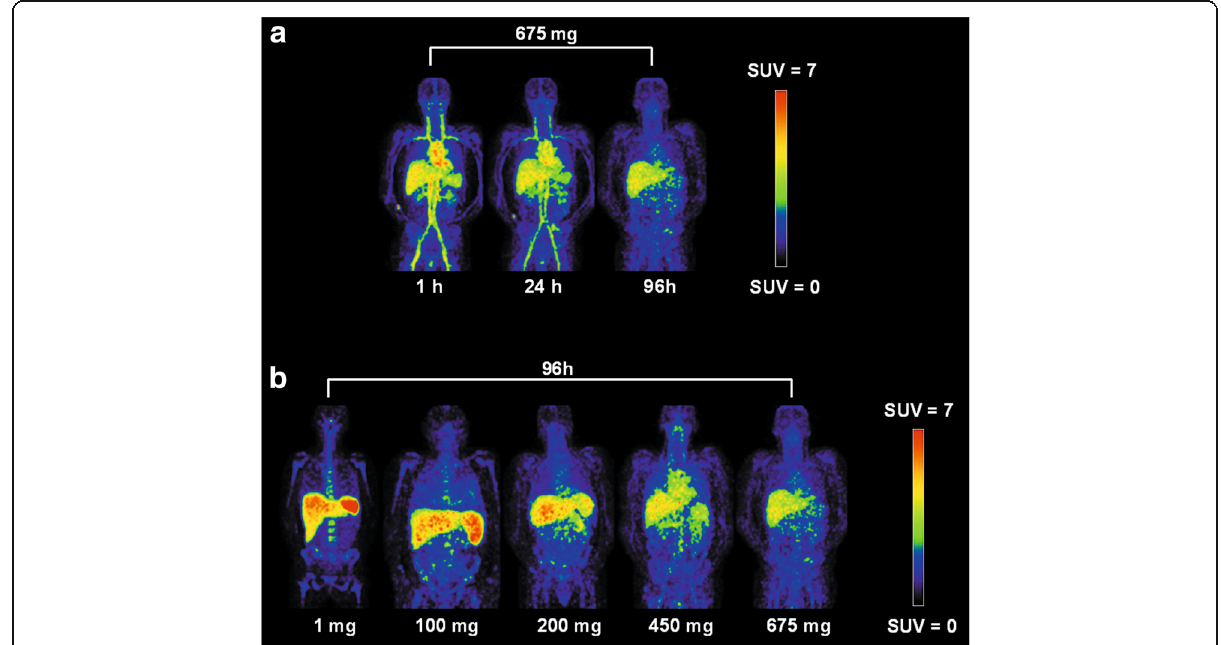
Fig. 2 Biodistribution of 89 Zr-labelled-RG7356. a As function of time: maximum intensity projections at 1, 24 and 96 h p.i. for patient 12 (675 mg dose cohort). b As function of total administered antibody dose: maximum intensity projections at 96 h p.i. for various dose cohorts (1, 100, 200, 450 and 675